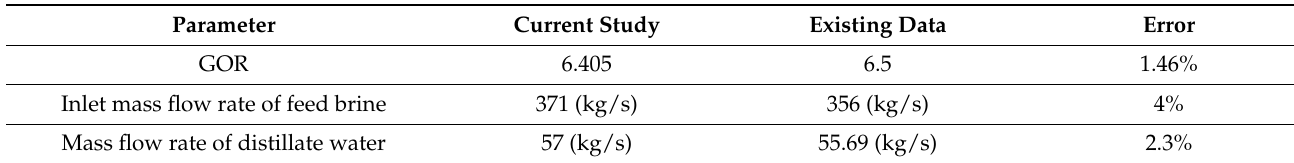
Table 6. Comparison of modeling results and real data.